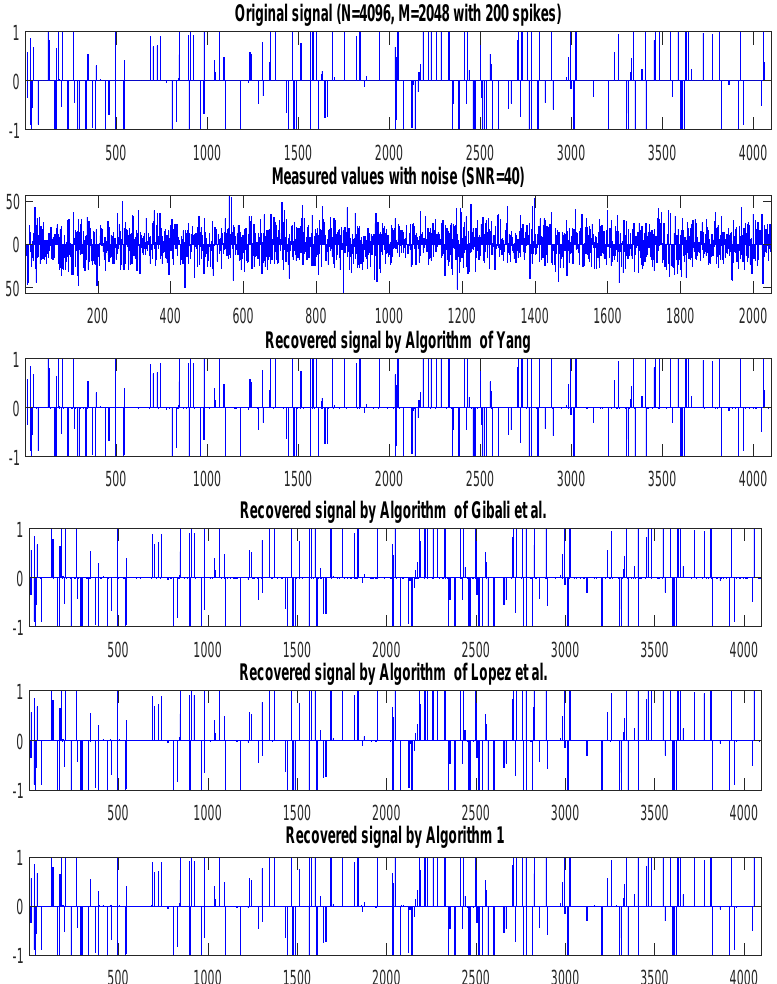
Figure 2. From top to bottom: original signal, observation data, recovered signal by Algorithms of Yang [8], López et al. [10], Gibali et al. [12], and Algorithm 1 with N = 4096, M = 2048 and m =